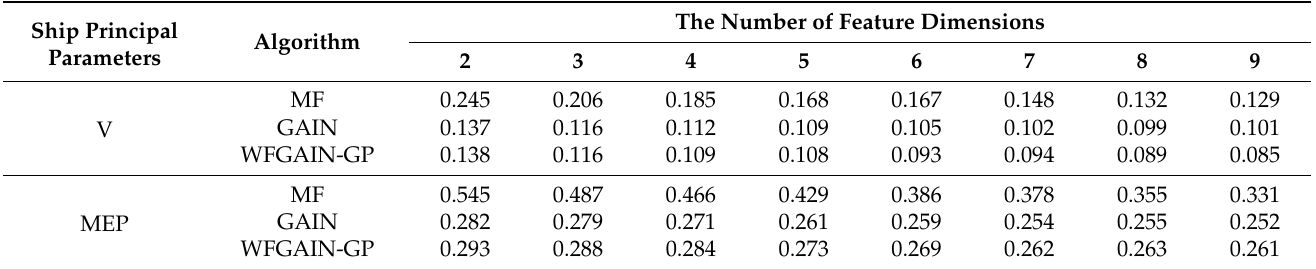
Figure 10. RMSE analysis plots for three models with a different number of features: ( a ) V and ( b ) MEP. Table 11. The RMSE values of the three models with a different number of features.